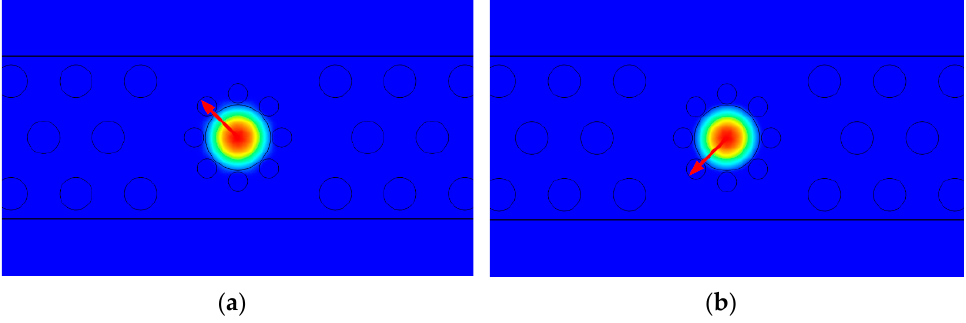
Figure 2. ( a ) Electromagnetic field distribution of the quasi-TE model; ( b ) electromagnetic field distribution of the quasi-TM model.